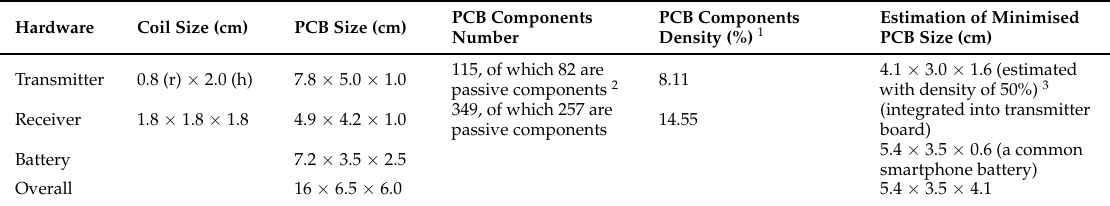
Table 2. Hardware improvement space for next generation of the